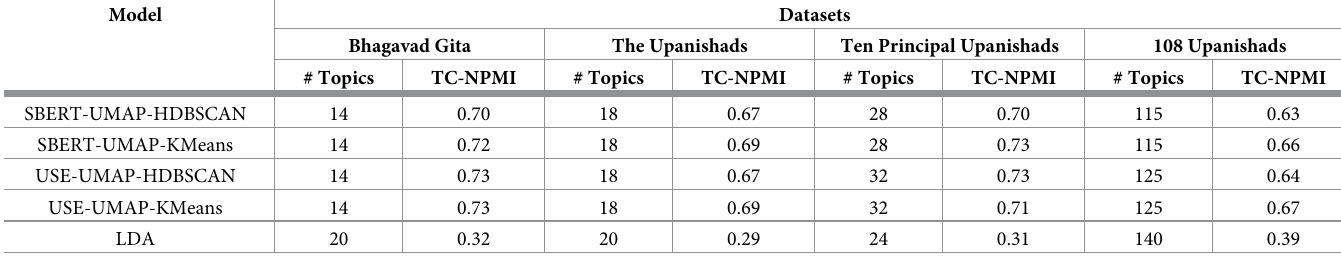
Table 4. Value of topic coherence metric (TC-NPMI) for different corpus.